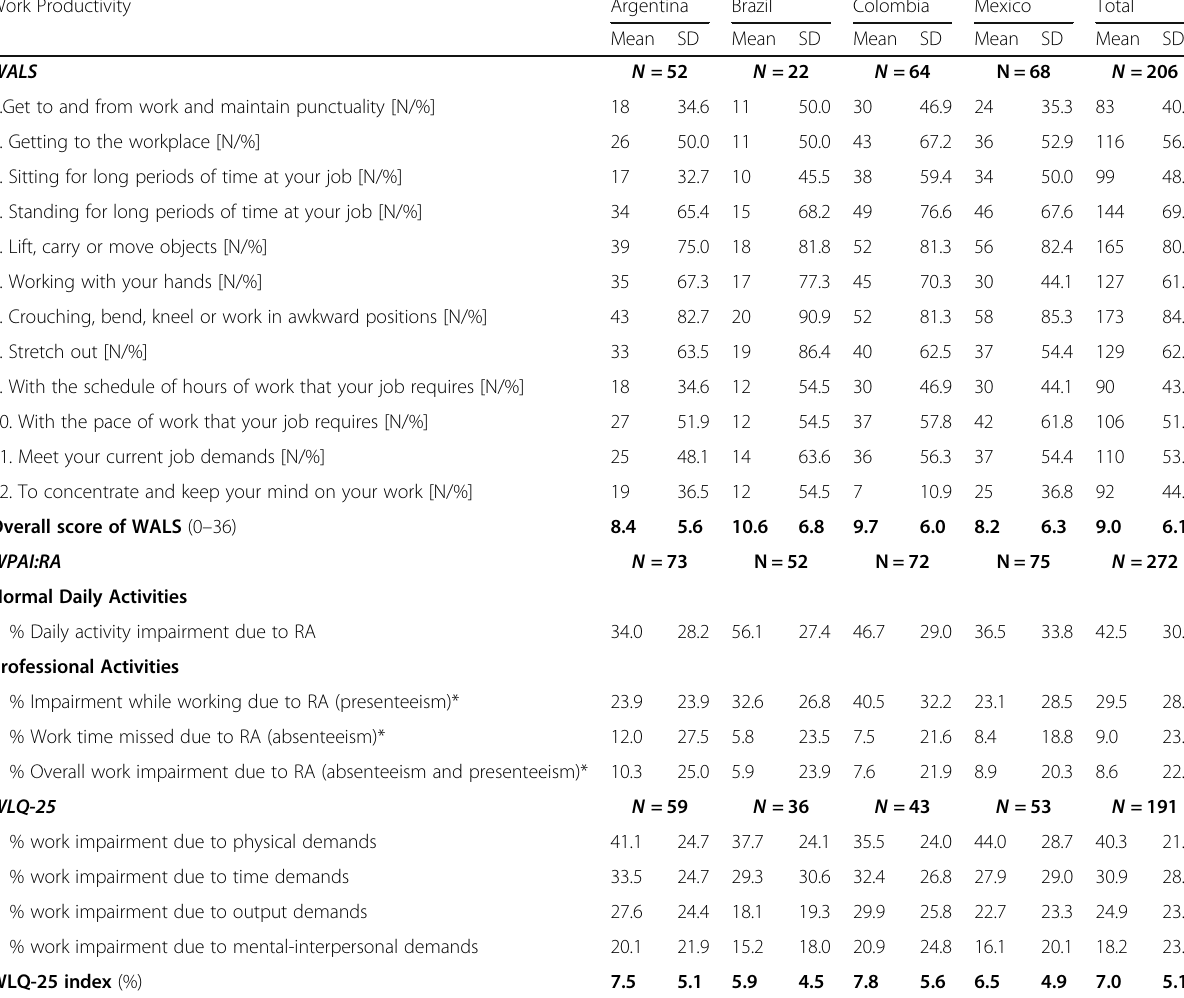
Table 3 Work productivity assessed through WALS, WPAI:RA and WLQ-25 questionnaires among RA patients at baseline Work